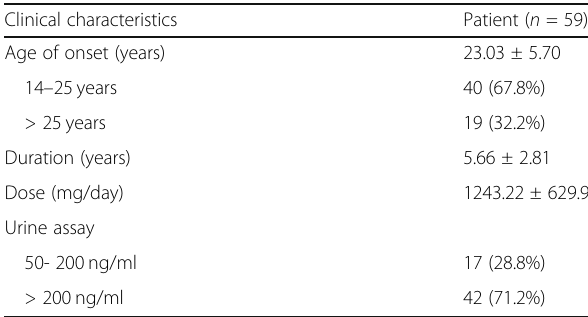
Table 2 Clinical characteristics of patient group Clinical